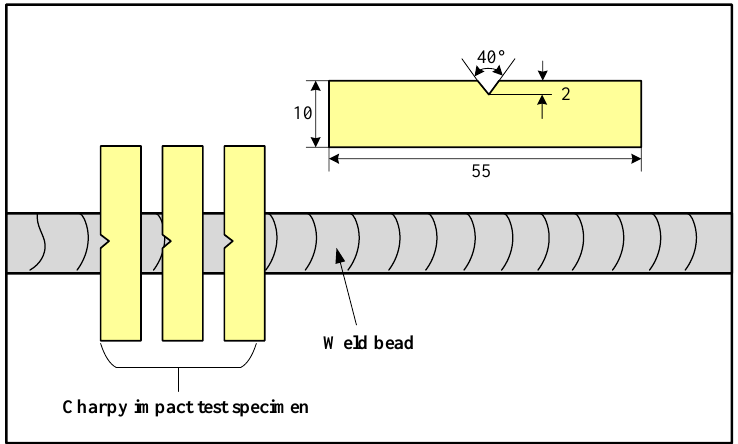
Figure 5. Dimensions of the Charpy impact test specimens.